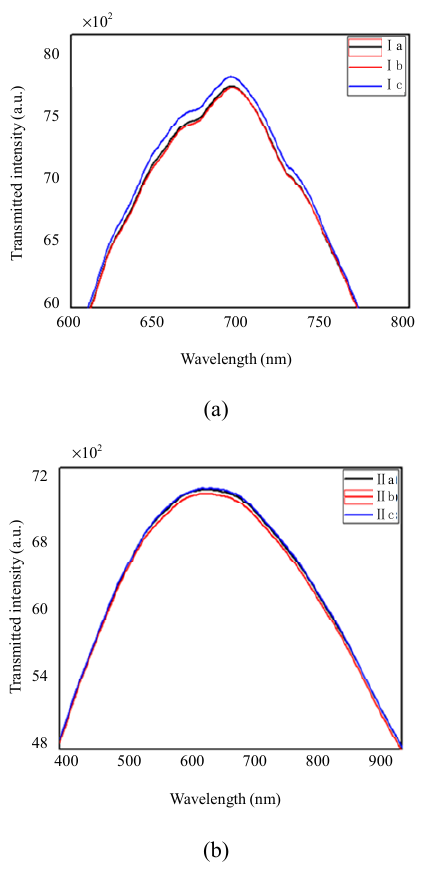
Fig. 16 Reproducibility test: (a) Probe I and (b) Probe II.